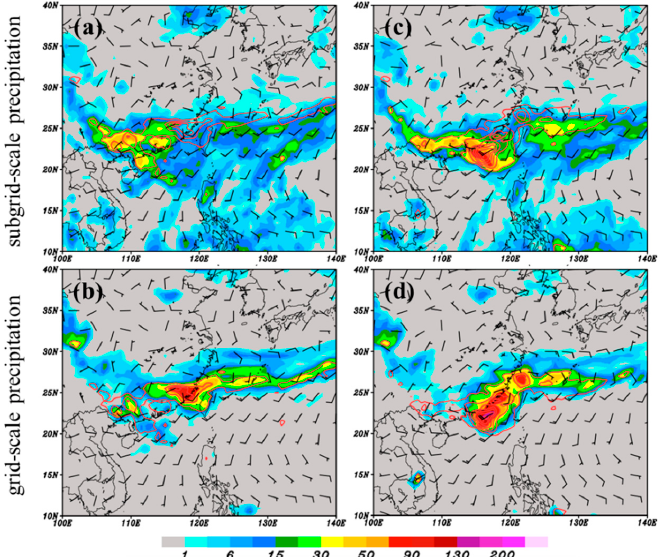
Figure 4. ( a ) Subgrid-scale and ( b ) grid-scale precipitation (colored; mm) for 48–72 h accumulated from the CTRL experiment on 21 May 2020. Red contours are the total precipitation (combination of subgrid-scale and grid-scale precipitation). ( c , d ) as in ( a , b ) but for the EXP experiment.